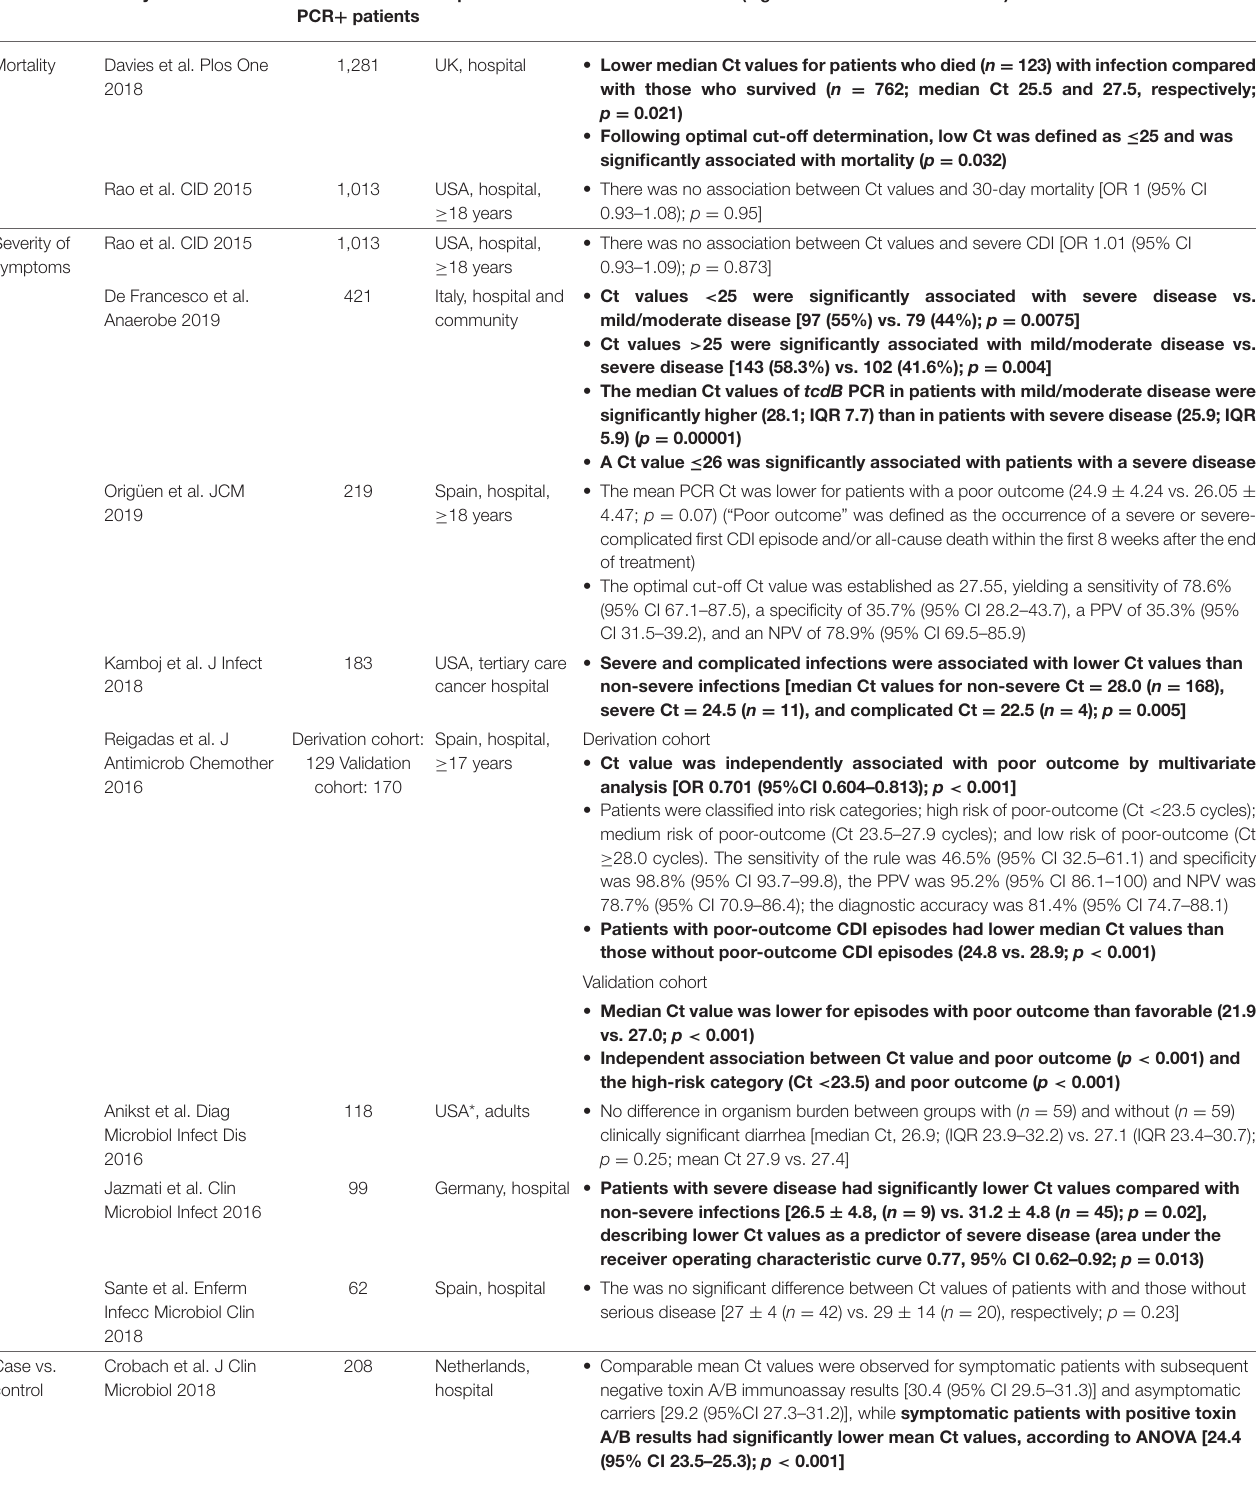
TABLE 1 | Summary of studies that assessed PCR Ct values for C. difficile infections against patient clinical presentation and